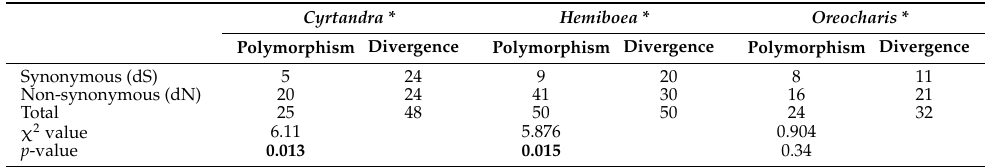
Table 1. McDonald–Kreitman tests of CrCYC1C haplotypes. Cyrtandra * Hemiboea * Oreocharis * Polymorphism